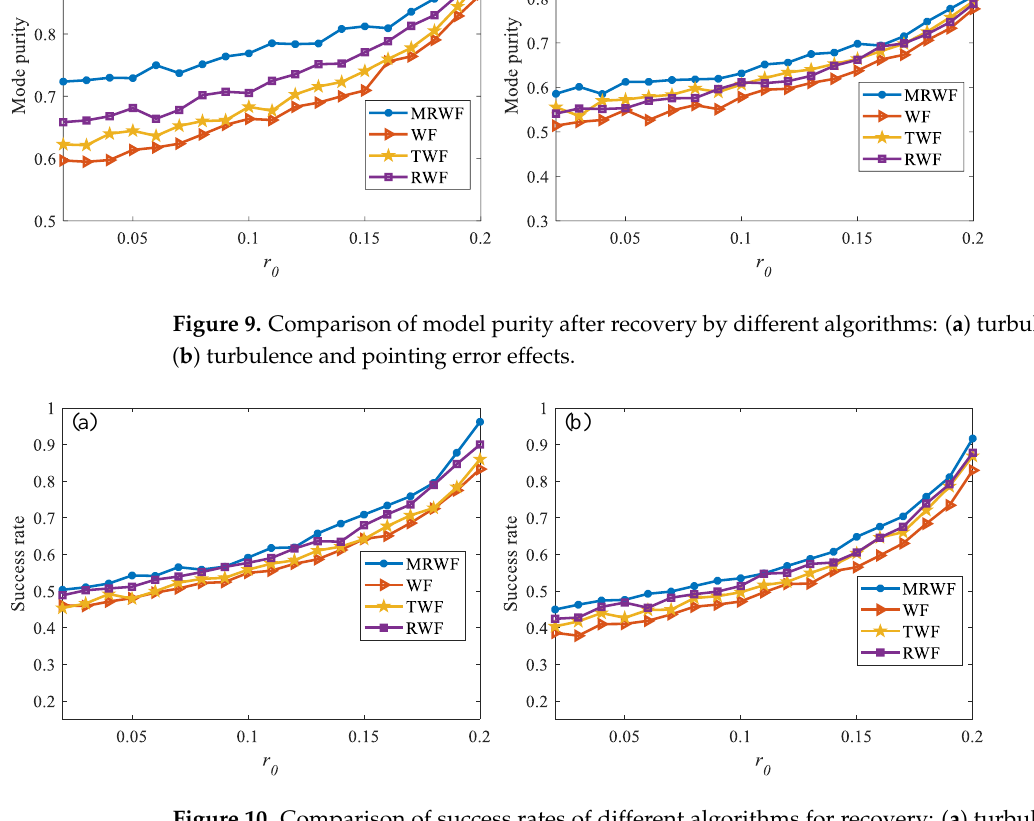
Figure 9. Comparison of model purity after recovery by different algorithms: ( a ) turbulence effects; ( b ) turbulence and pointing error effects.